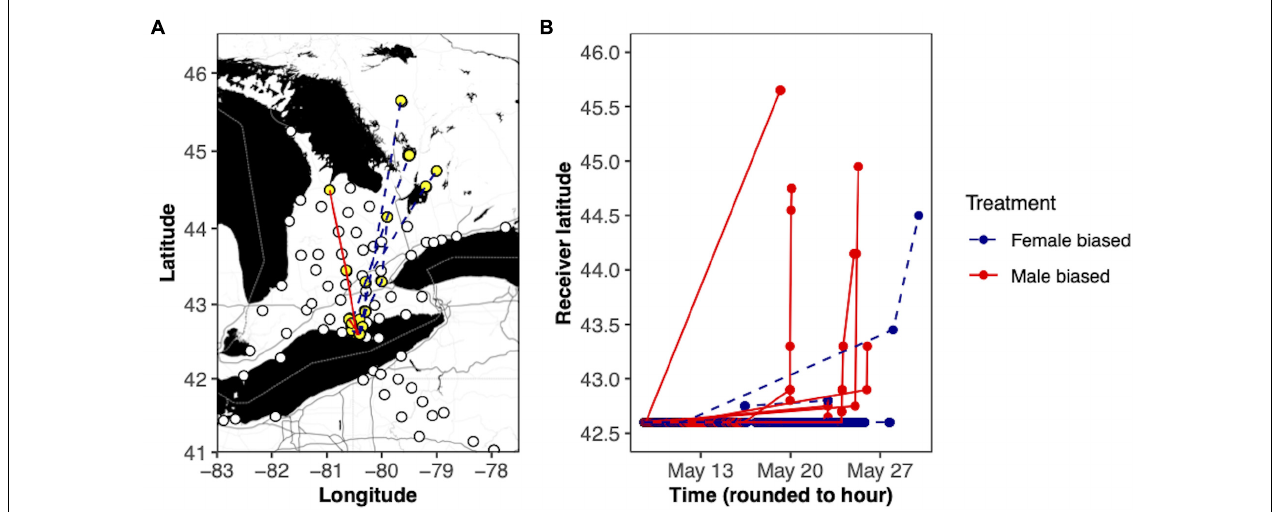
FIGURE 7 | Movement of yellow-rumped warblers ( Setophaga coronata coronata ) after being released at simulated stopover on Long Point, ON, on 8 May 2019. Panel (A) shows the movement paths of the birds after departing Long Point. The white circles represent active receiver stations in the region at the time of the study. The yellow circles and associated connected lines represent receiver stations with detections and the individual tracks. Panel (B) shows the movement timing of the birds. For both panels, birds from the female biased treatment are represented by the blue dashed lines and the birds from the male biased treatment by the red solid